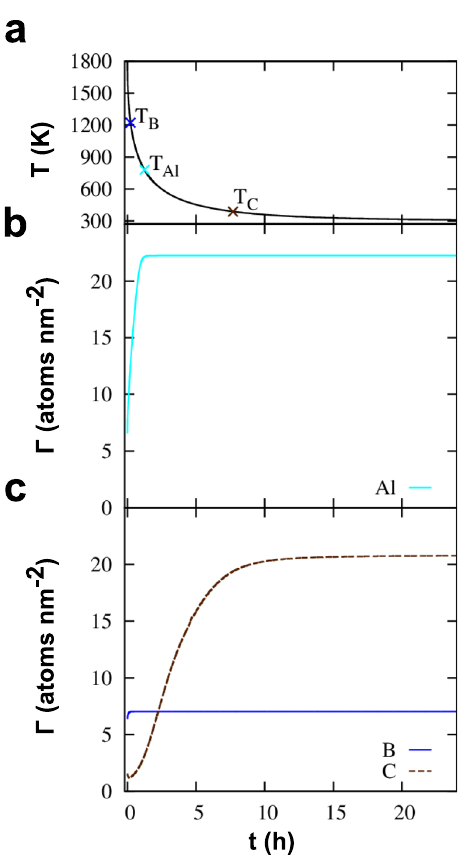
Fig. 10 Computed grain boundary segregation kinetics. a Time- temperature curve during cooling with the temperatures T sol marked at which segregation for the solutes is limited kinetically. b The resulting enrichment of Al atoms without interaction with other solutes. c Competing temperature dependent segregation of C and B while the bottom panel shows the enrichment for competing B and C